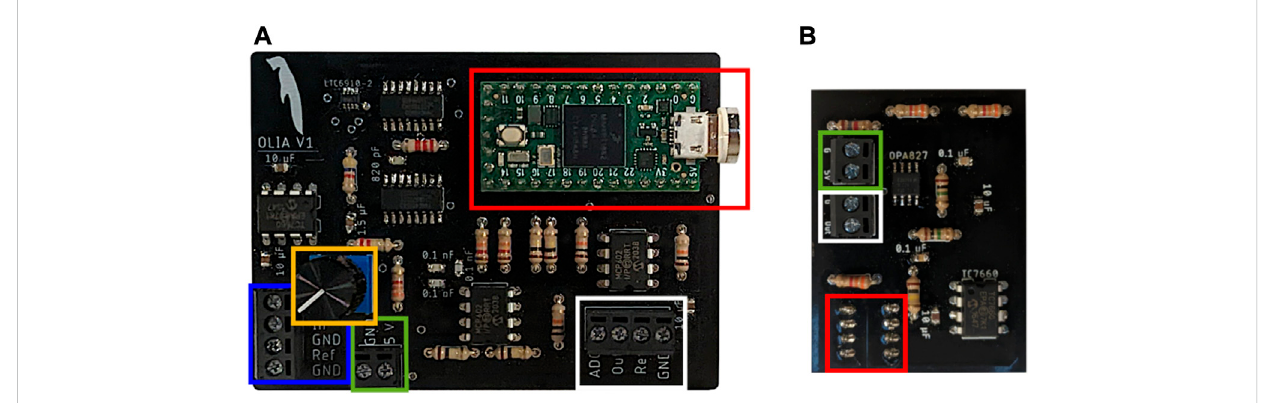
FIGURE 2 (A) Photograph of OLIA ’ s fully assembled printed circuit board (PCB). Inputs and outputs are made via two 4-pin terminal blocks (blue and white boxes,respectively).A2-pinterminalblock(greenbox)providespowerpass-throughfromtheUSBportoftheTeensy4.0(redbox),whichisusedtoboth power the device and provide a connection to an external computer for data handling. We recommend using a quick-connect magnetic USB cable and connector as shown in the photo to prevent damage to the fragile micro-USB connector from repeated connection and disconnection. A potentiometer (yellow box)isusedtobring OLIAinto alockconditionwithanexternal reference signalwhenitisoperatinginexternal referencingmode. (B) Photograph ofbreak-outboardfor opticaldetection. Terminalblocksareused to supply power (green box) to theintegrated DC servocircuit